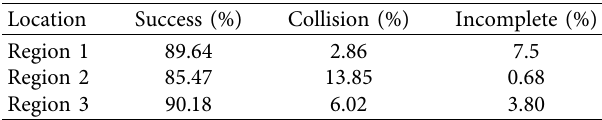
Figure 6: Success rate of the proposed method under random target point test. (a) Success rate of obstacle avoidance training. (b) Success rate of navigation training. Table 4: Test results in different regions under the random target point